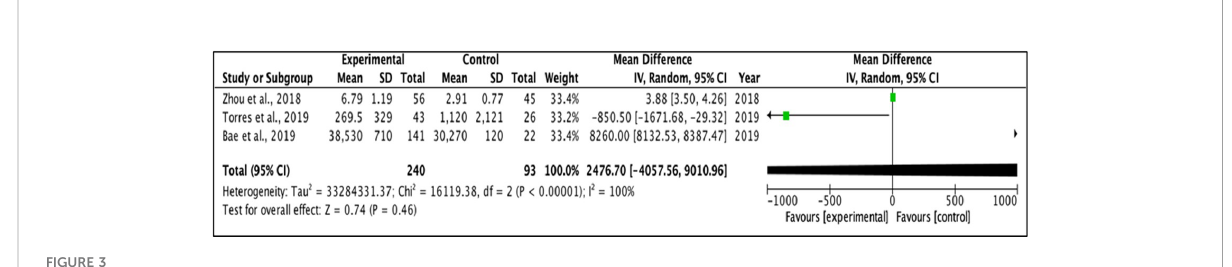
FIGURE 3 Forest plot for analysis of IL-1 b levels.